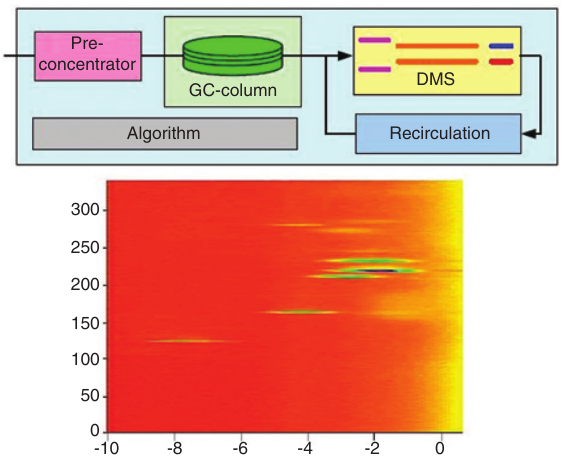
Figure 1: Instrumental implementation of GC-DMS